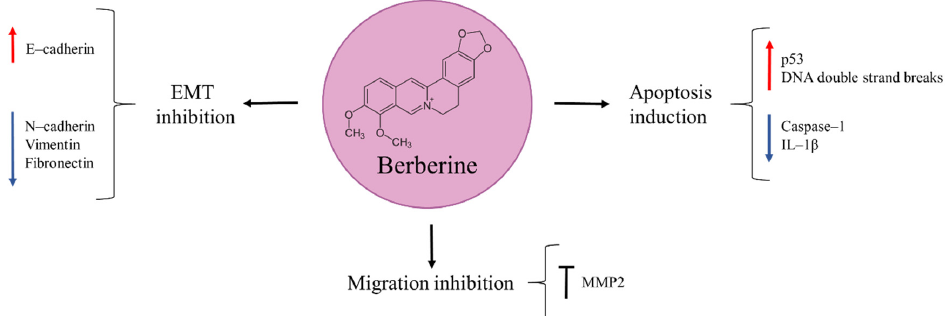
Figure 7. Berberine in osteosarcoma